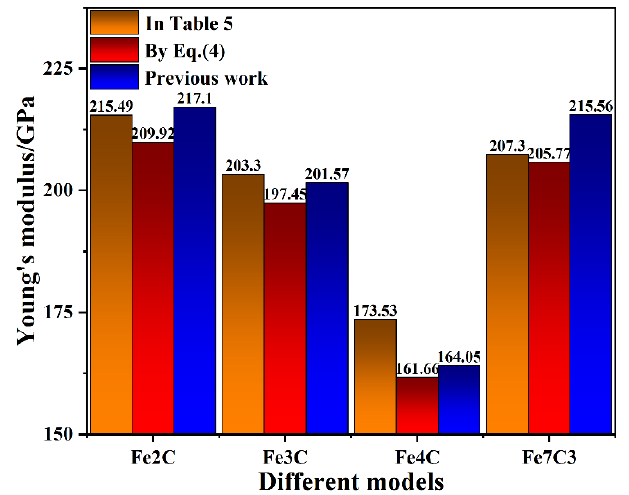
Figure 6. The fitted Young’s modulus values of the ferrite – carbide composite model.